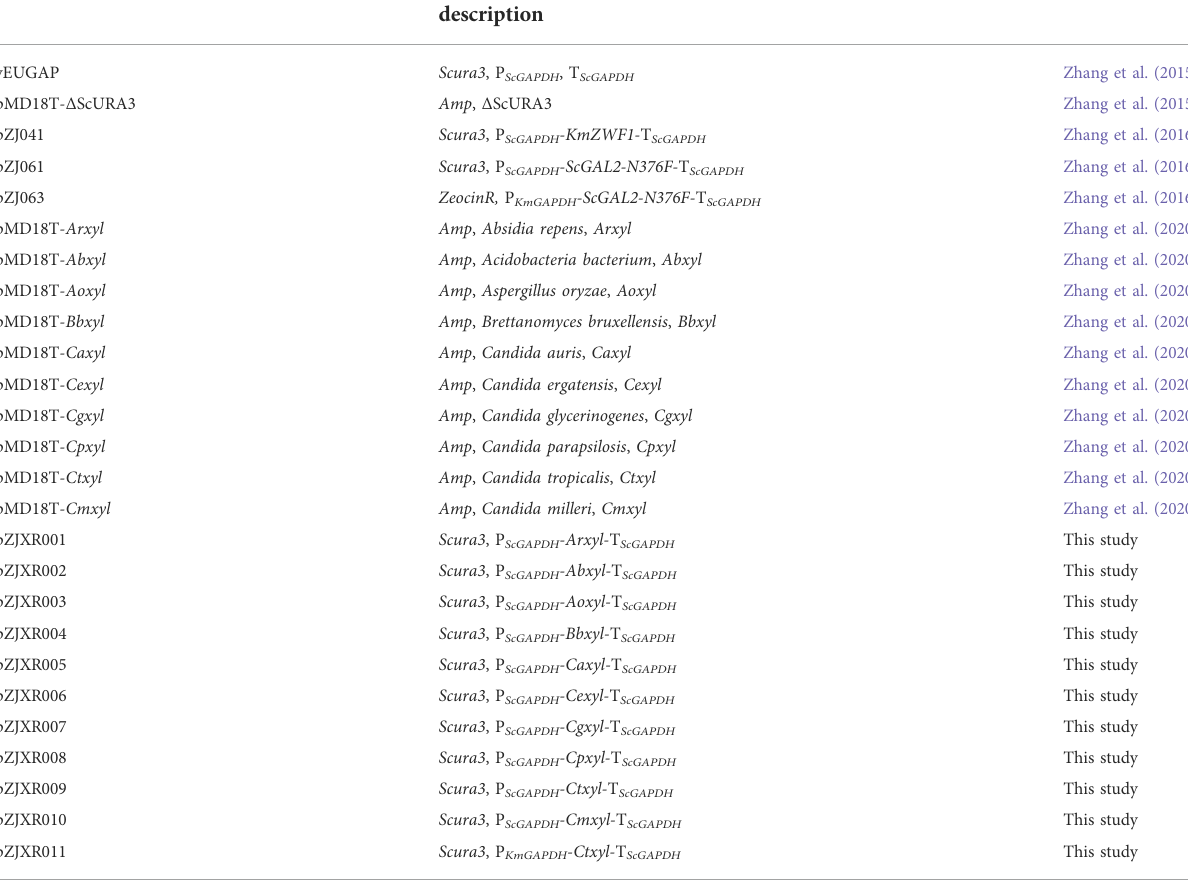
TABLE 2 Plasmids used in this